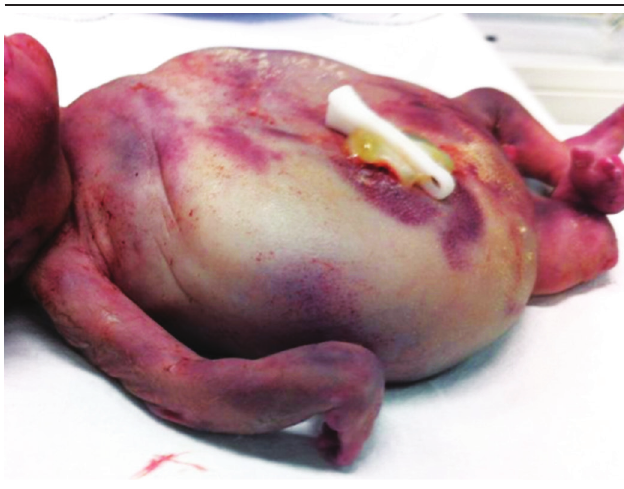
figurE 3 − Postnatal physical aspect of the infant showing significant distension of the abdomen and upper and lower limb abnormalities